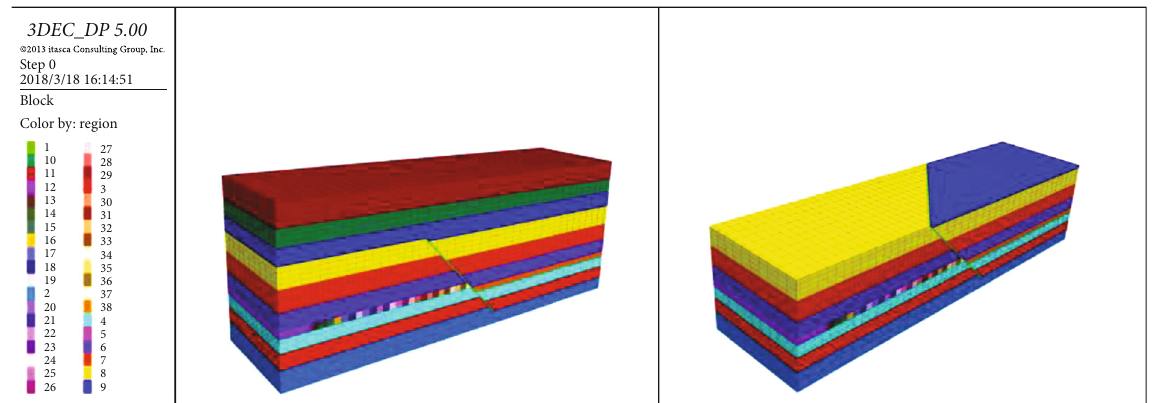
Figure 2: Numerical calculation model diagram of coal and gas outburst on mining